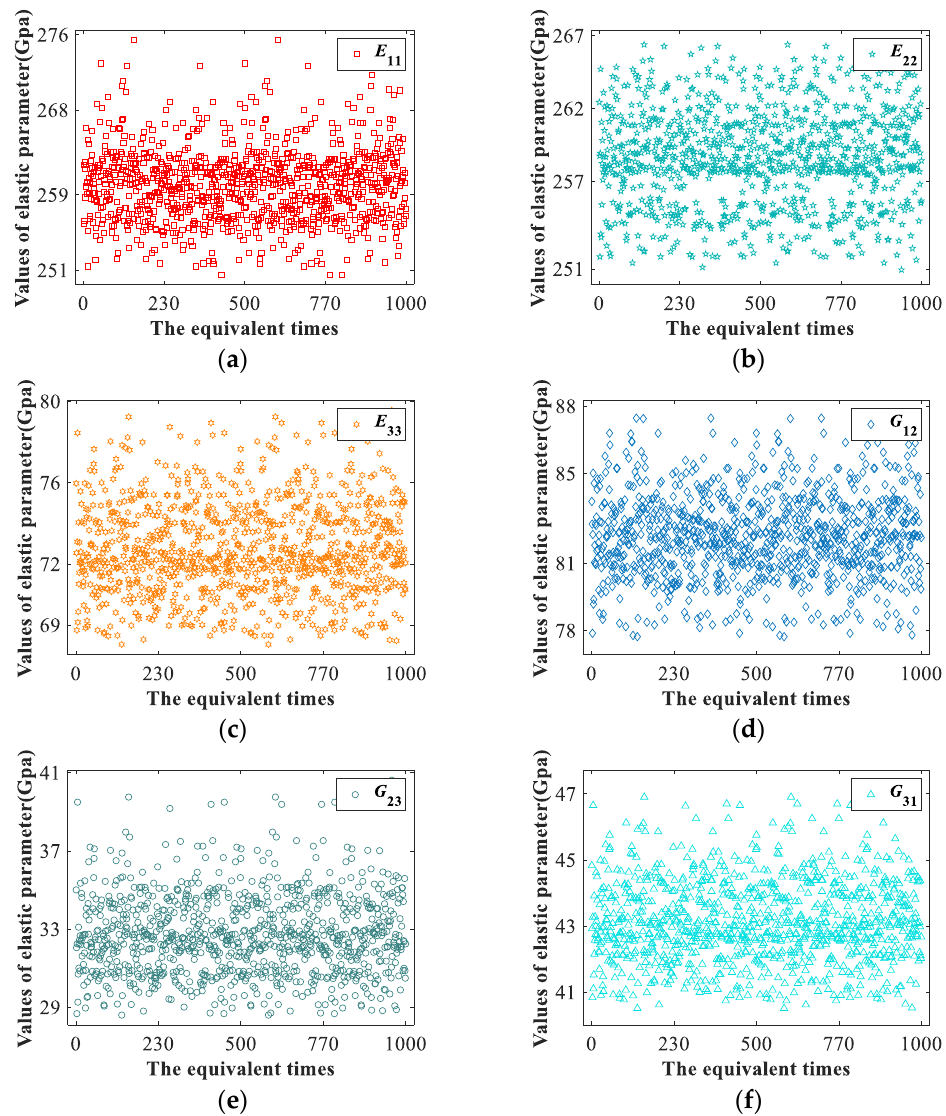
Figure 13. The scatter plots for equivalent elastic parameters. ( a ) Scatter diagram of E 11 equivalent results. ( b ) Scatter diagram of E 22 equivalent results. ( c ) Scatter diagram of E 33 equivalent results. ( d ) Scatter diagram of G 12 equivalent results. ( e ) Scatter diagram of ν 12 equivalent results. ( f ) Scatter diagram of α 11 equivalent results. Table 11. Statistics of equivalent elastic parameters of 2.5D braided composites.